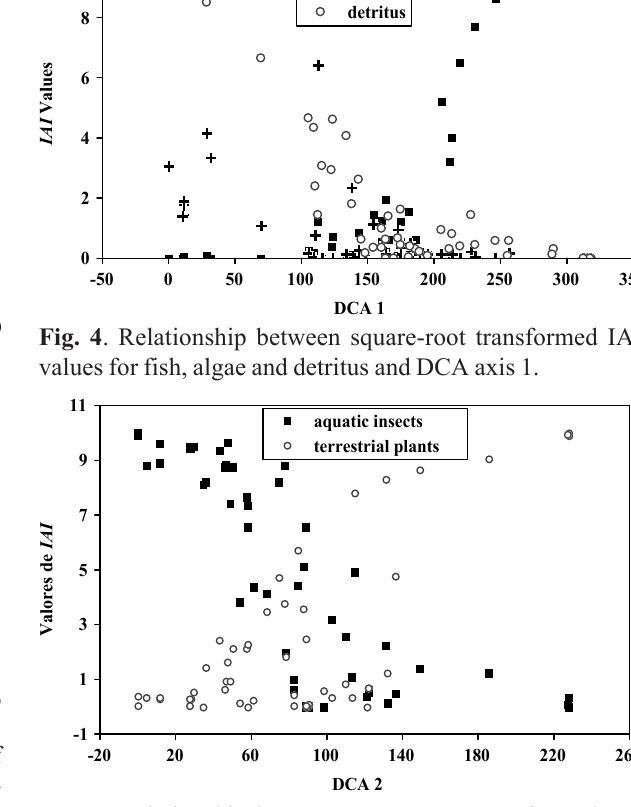
Fig. 5. Relationship between square-root transformed IAi values for aquatic and terrestrial insets and DCA axis